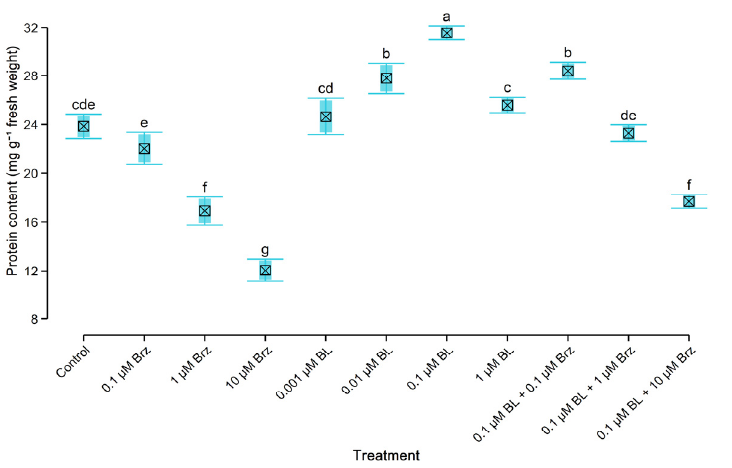
Figure 2. The effect of BL and/or Brz on protein content in W. arrhiza after 7 days of cultivation. The crossed square shows the mean ( n = 5). The lower and upper hinges correspond to the lower and upper bounds of 95% confidence interval of the mean. The lower and upper whiskers extend from the hinge to mean ± standard deviation. Means with the same letters are not significantly different ( p ≥ 0.05) according to Tukey’s post hoc test.